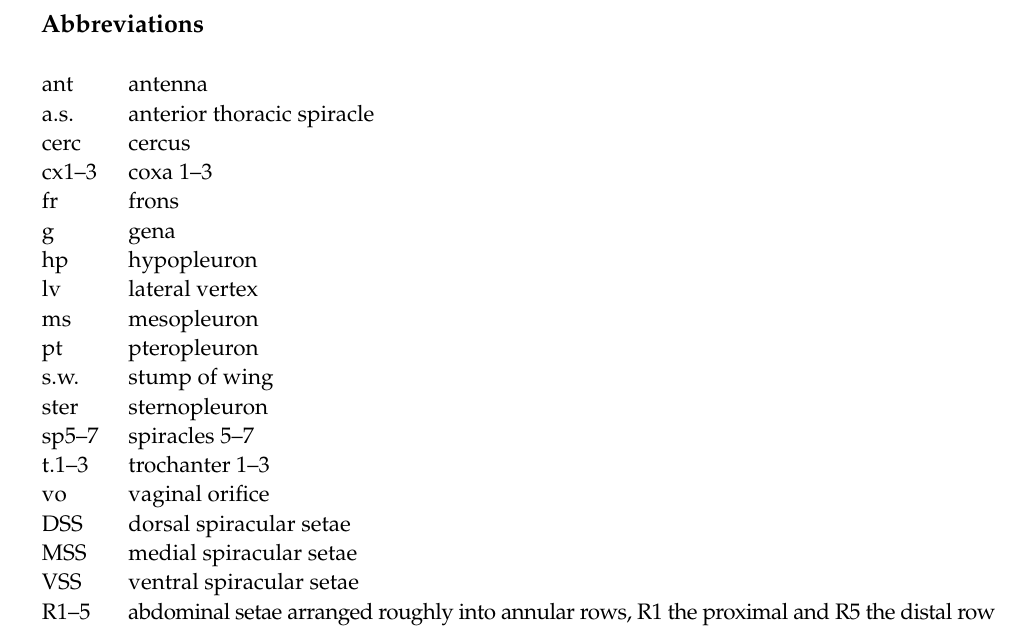
abdominal setae arranged roughly into annular rows, R1 the proximal and R5 the distal